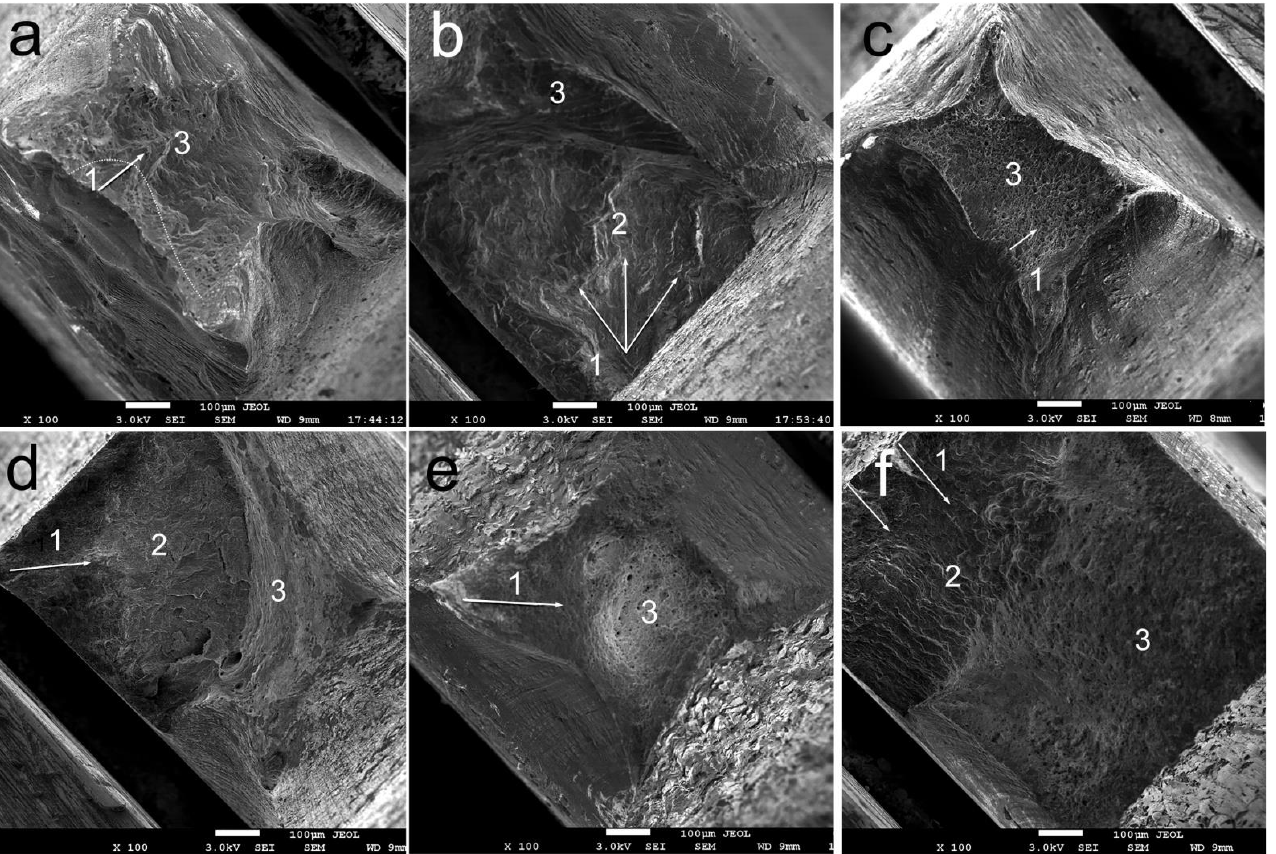
Figure 7. Fracture surfaces of fatigue failure of the Cu-0.5%Cr-0.08%Zr samples after quenching (( a ) stress is 200 MPa, N = 1.7 × 10 5 ; ( b ) stress is 145 MPa, N = 6.4 × 10 6 ), extrusion + quenching + RS (( c ) stress is 375 MPa, N = 3 × 10 4 ; ( d ) stress is 275 MPa, N = 1.5 × 10 6 ) and extrusion + RS (( e ) stress is 575 MPa, N = 3 × 10 4 ; ( f ) stress is 385 MPa, N = 1.5 × 10 6 ). The white arrows indicate the fatigue crack propagation direction.